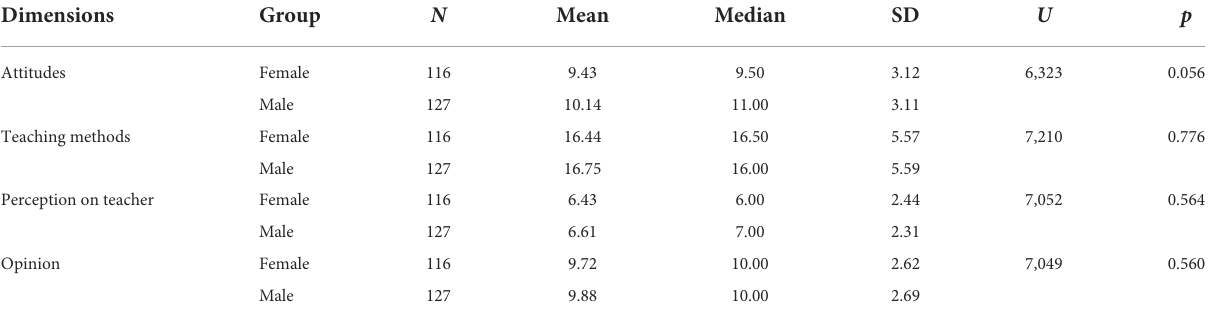
TABLE 3 Mann–Whitney U results according to